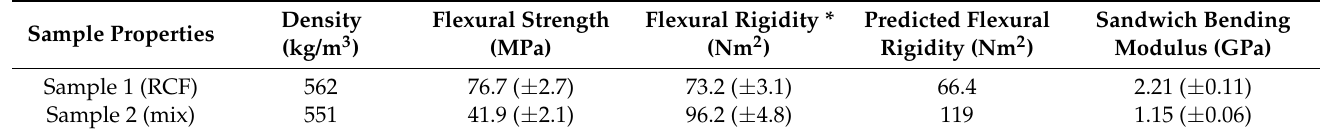
Table 2. Properties of the sustainable sandwich composites.